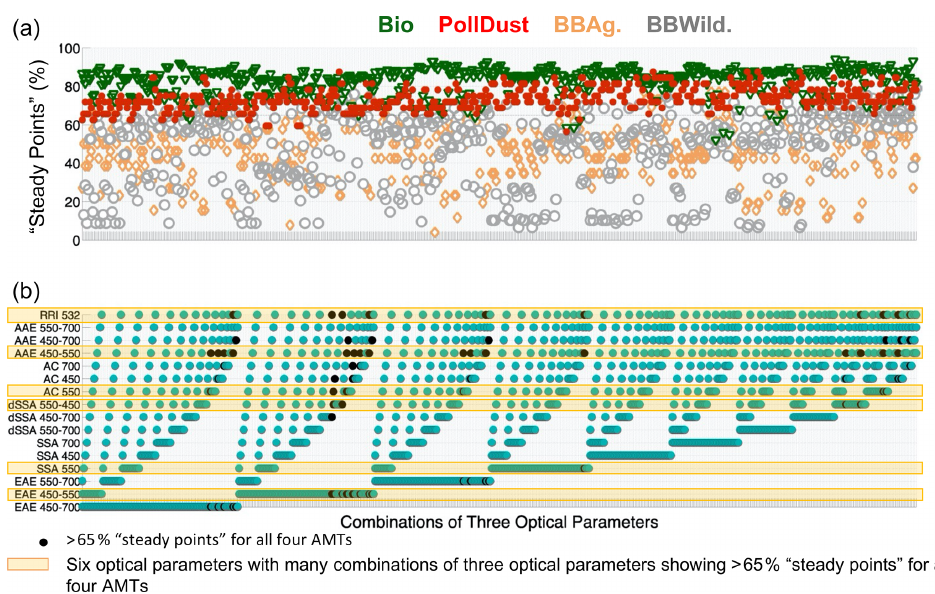
Figure A6. Percentage of steady points (i.e., fraction of cases of a given type that are correctly identified; see Sects. 2.2 and A1.3 for more info) in panel (a) when using different combinations of three aerosol optical parameters in panel (b) for each PS-AMT. Black points are combinations of optical parameters showing > 65% steady points for PS-AMTs BBAg., BBWild., Bio. and PollDust. RRI: real refractive index; AAE: absorption Ångström exponent; AC: absorption coefficient; dSSA: difference in single scattering albedo; SSA: single scattering albedo; EAE: extinction Ångström exponent. Horizontal orange boxes show the six aerosol optical parameters that we have selected in this